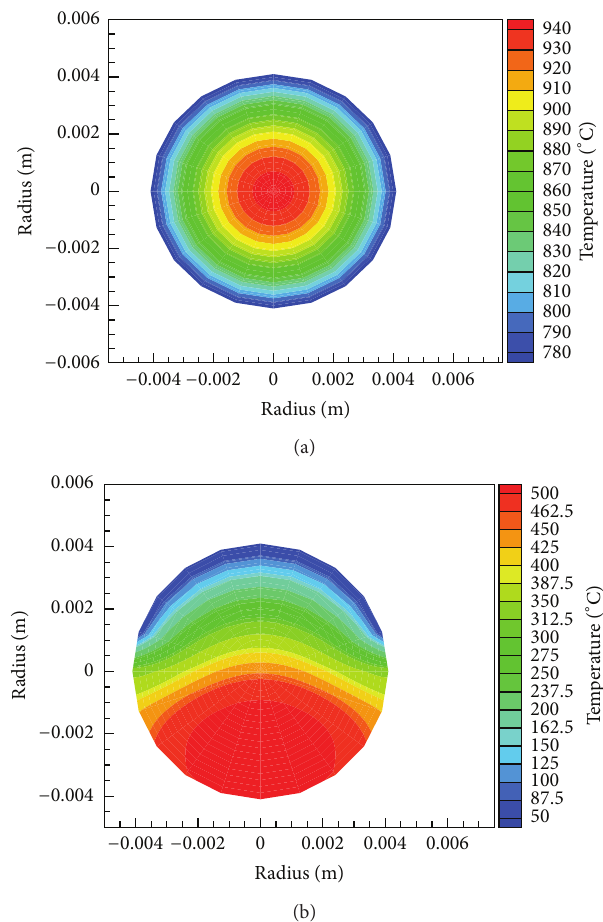
Figure 9: Influence of circumferential rewetting on fuel centre line